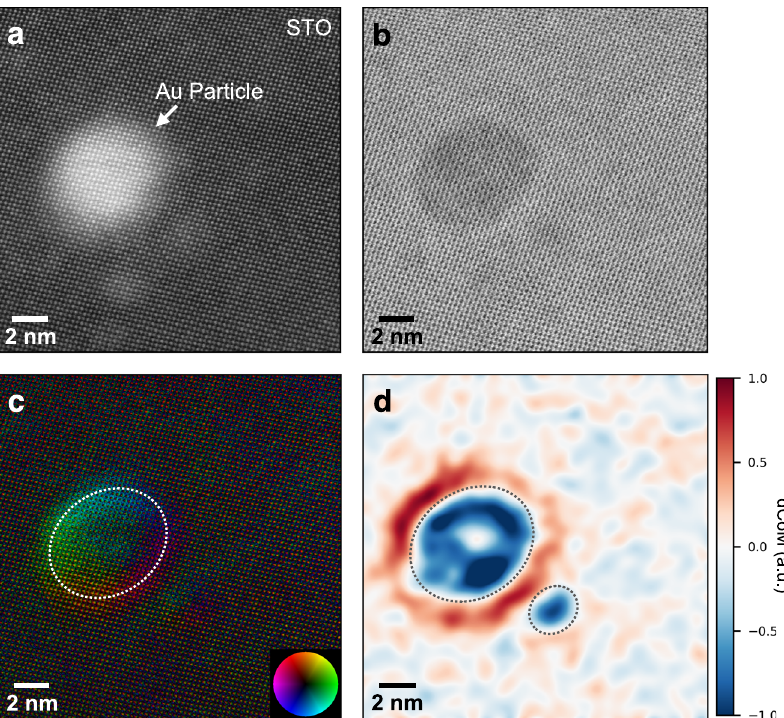
Fig. 2 Atomic-scale STEM images and inverted CoM map acquired simultaneously in a 4D-STEM dataset, as well as fi ltered inverted dCoM map, of Au nanoparticle on STO. a ADF-STEM and b BF-STEM images reconstructed from the 4D data. c Atomic-scale CoM map with direction and strength indicated by color and intensity, respectively (direction inverted from raw CoM to display features associated with electric fi elds appropriately, since the beam electrons are negatively charged). d Inverted dCoM map after application of a 4 Å Gaussian fi lter to isolate nanometer-scale features from the underlying atomic-scale information (see Supplementary Fig. 1 for a comparison with the original atomic-resolution map). The particles appear negative in projection, with the surrounding support positive. Dashed lines represent the approximate particle